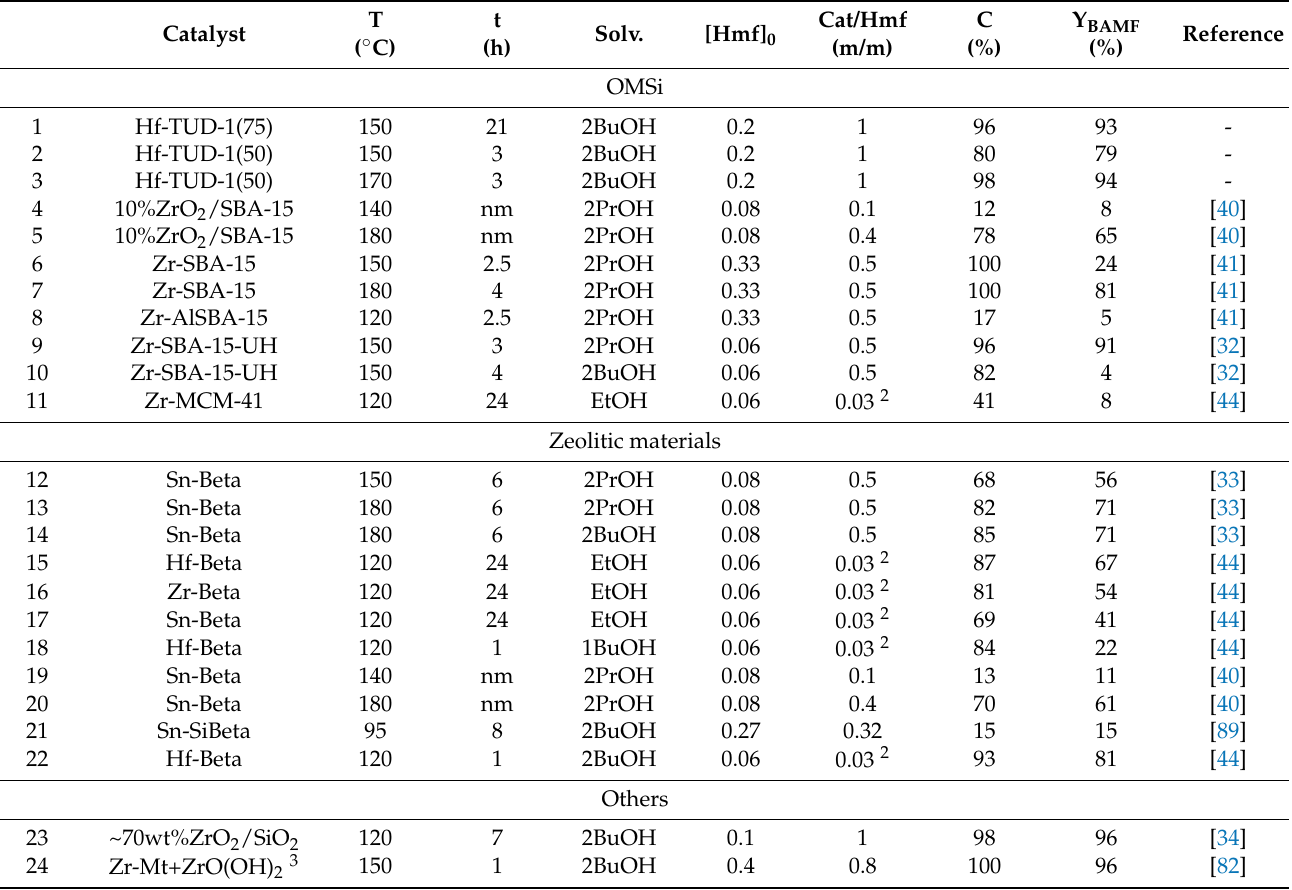
textural and, acid (Table S2) and morphological (Figure S16) properties, metal distributions (element maps, Figure S16), and Si/Hf ratio (Table S2) to the respective original catalysts. Consistently, a contact test (using 2BuOH at 150 ◦ C/3 h; please see Section 3.3 for details) indicated that no soluble active species were present in the liquid phase since the solution (obtained by contacting the solid catalyst with the solvent under catalytic conditions (without Fur), followed by catalyst separation and, finally, by the addition of Fur to the liquid phase without the solid catalyst) led to similar conversion to the blank test without catalyst (<1%). Table 3. Best catalytic results for Hf-TUD-1(x) and comparison with literature data for the conversion of Hmf to BBMF in alcohol medium over fully inorganic non-noble heterogeneous catalysts 1